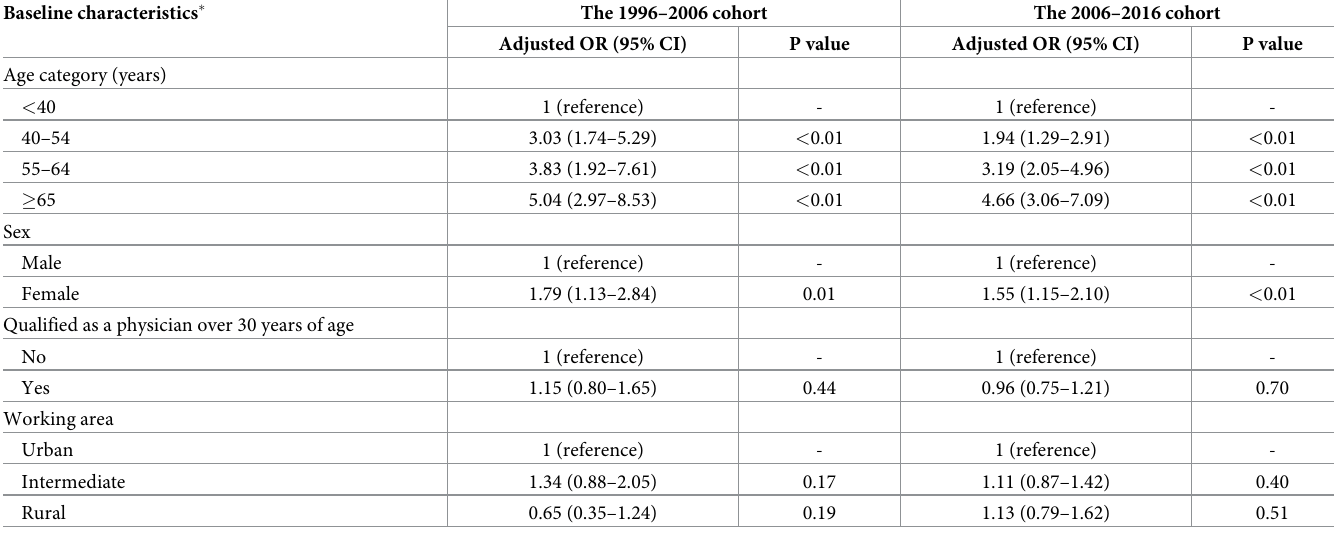
Table 5. Multivariable logistic regression analysis to identify physician factors associated with continuing to work in GHSFs 10 years later. Baseline characteristics